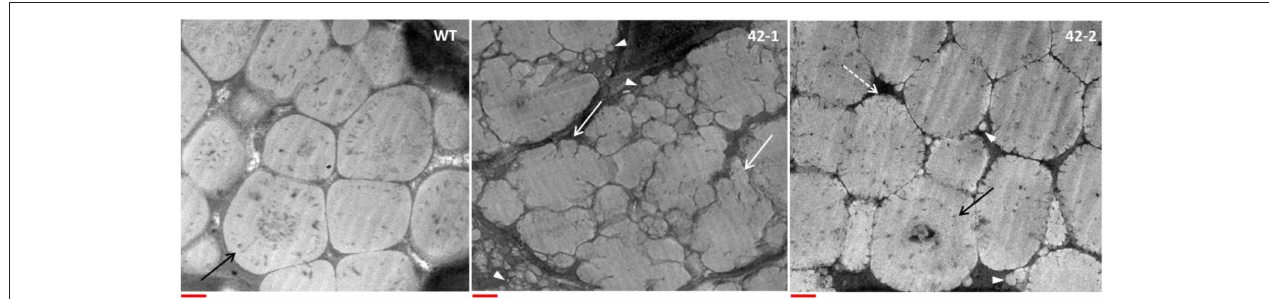
FIGURE 2 | Representative TEM images of protein bodies in the subaleurone layer of the wild-type (WT) and transgenic sorghum lines (42-1, 42-2). Black arrow points to internal concentric ring structure present in WT and some transgenic protein bodies. White arrows point to irregularly shaped protein bodies with invaginations at the periphery. “Cracked” peripheral structure of transgenic protein bodies, pointed out with white dotted arrow. White arrowheads point out the presence of small protein bodies ( < 0.5 µ m diameter) in the transgenic lines. Scale bar represents 0.5 µ m.